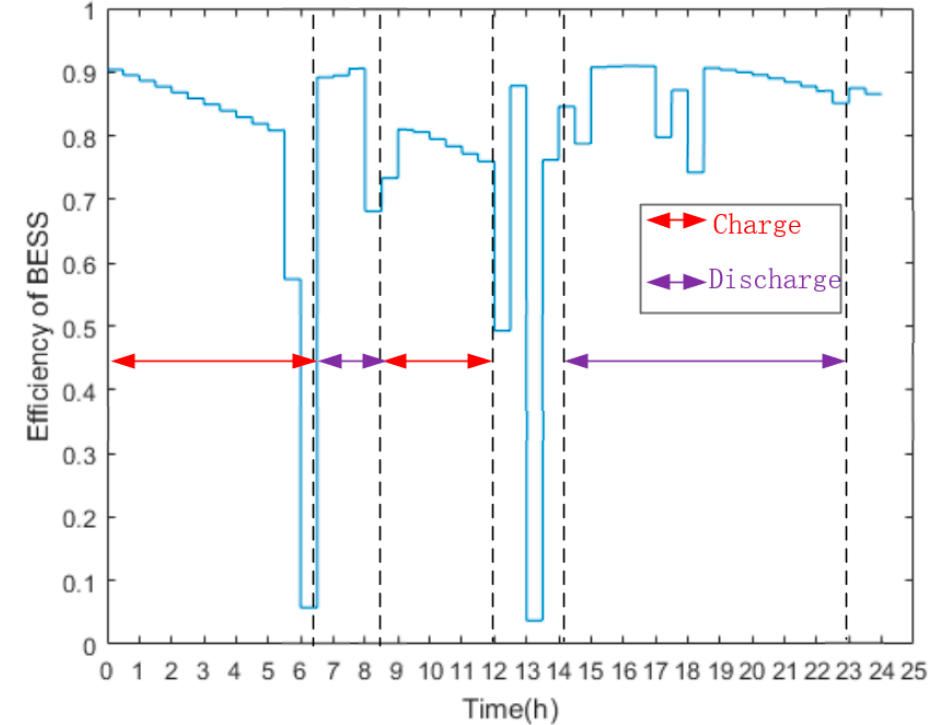
Figure 7. Output efficiency curve of VRB.